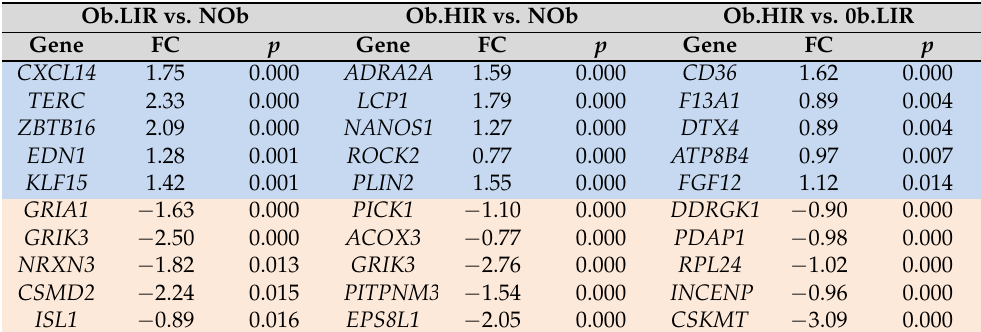
Table 1. Top 5 concordant genes (between mRNA and H3K4m3 changes) among study groups. In blue and cream, genes with enriched and decreased H3K4me3 mark, respectively, for each comparison between groups. Ob.LIR vs. NOb Ob.HIR vs. NOb Ob.HIR vs. 0b.LIR Gene FC p Gene FC